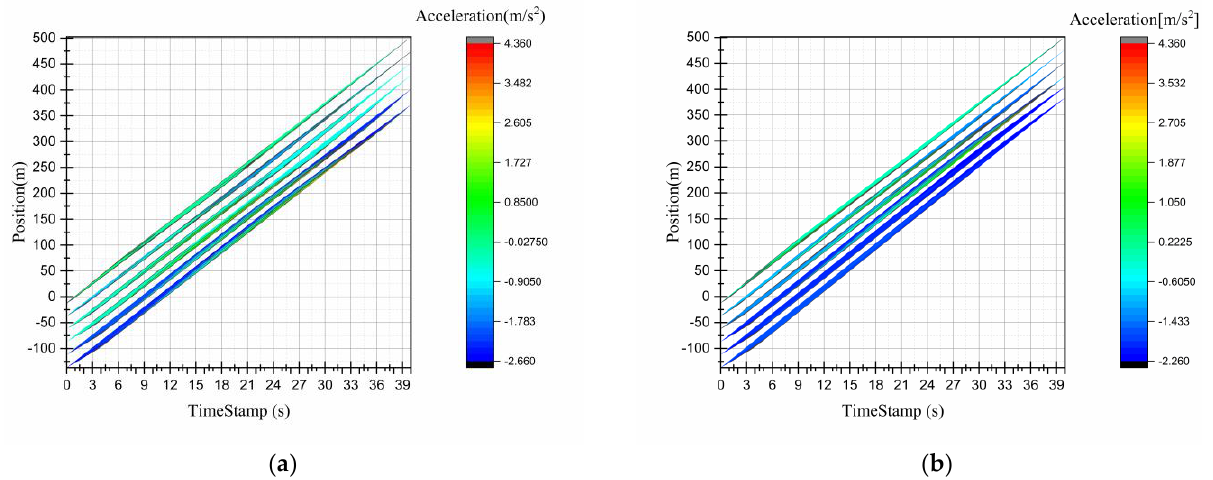
Figure 16. Acceleration heatmaps of CAVF fleet and CACCNF fleet under scenario 3: ( a ) CAVF acceleration heatmap; ( b ) CACCNF acceleration heatmap.